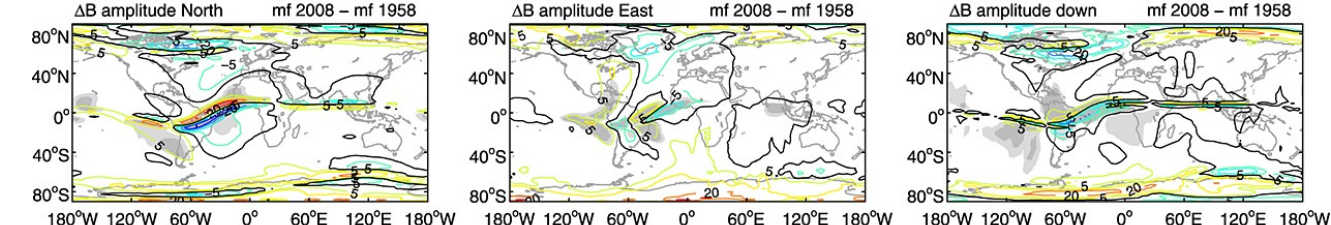
Figure 7. Maps showing the difference of the 15 ‐ day mean hmF2 ( left ) and foF2 ( right ) in 2008 with 1908 at 14:00 UT. Light (dark) shading indicates 95% (99%) statistical significance. (Reproduced from Cnossen and Richmond [81]: Figure 3, modified).